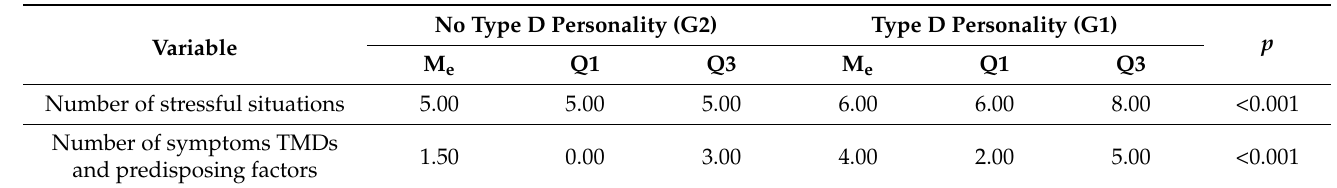
Table 4. Analysis of the number of stressors and the number of TMDs and predisposing factors in G1 and G2.